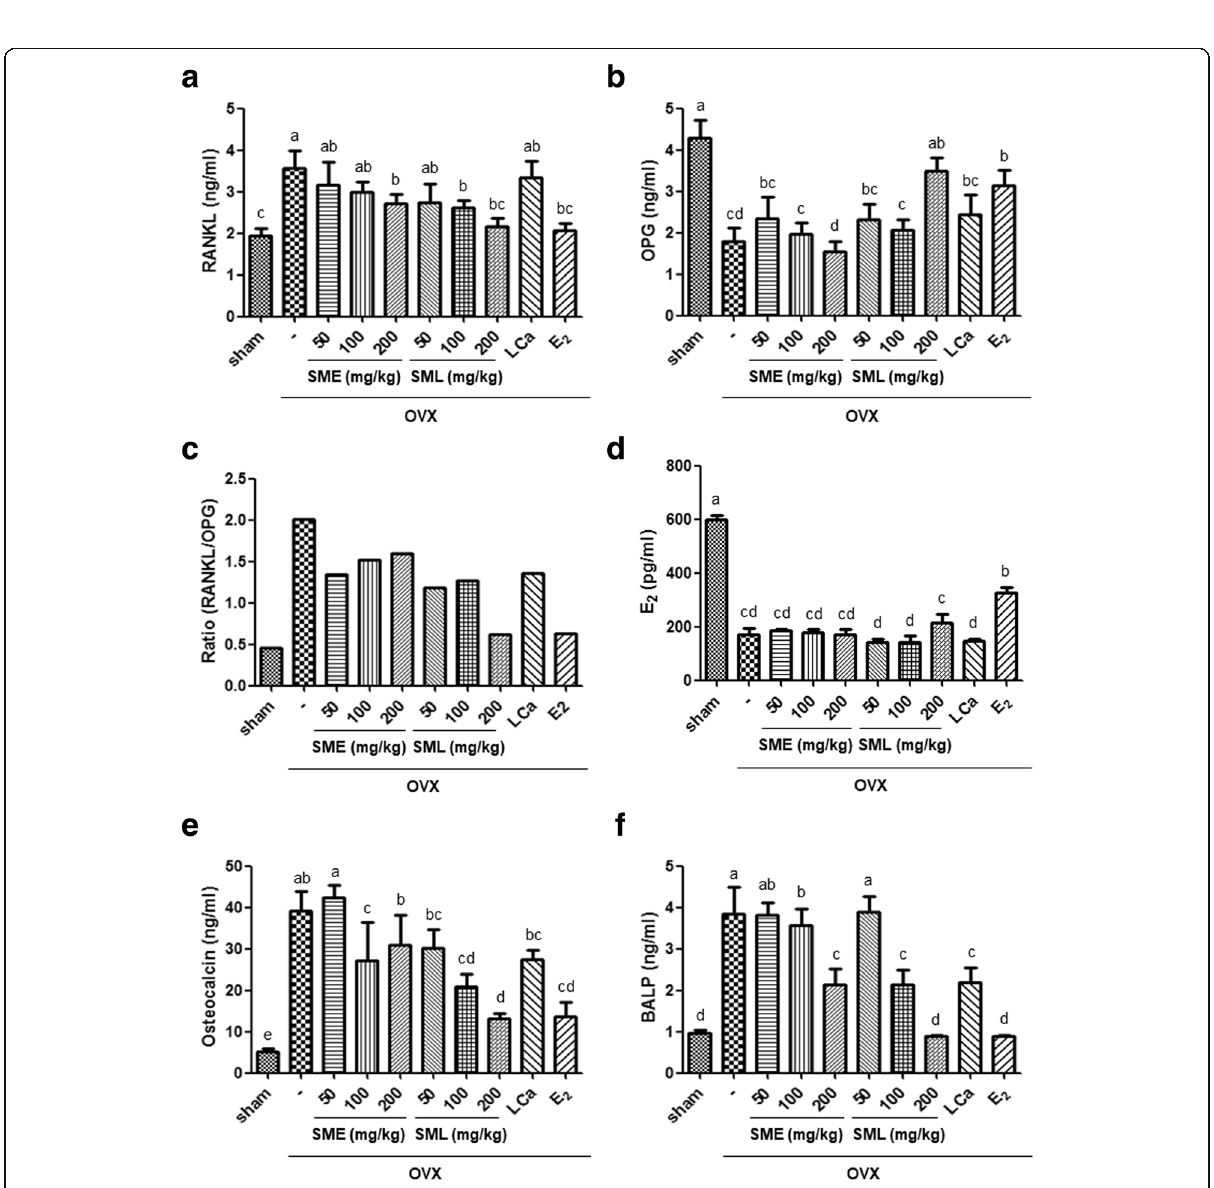
Fig. 4 Effects of SML on serum biochemical markers in OVX mice. a RANKL and b OPG were determined by murine RANKL and OPG ELISA assays using serum, and c the RANKL/OPG ratio was calculated. d E 2 , e osteocalcin, and f BALP were determined by murine ELISA assays. Data are the mean ± S.E.M. of three independent experiments (n = 7) for all groups. Means unlike letters in a column with differ significantly ( p <